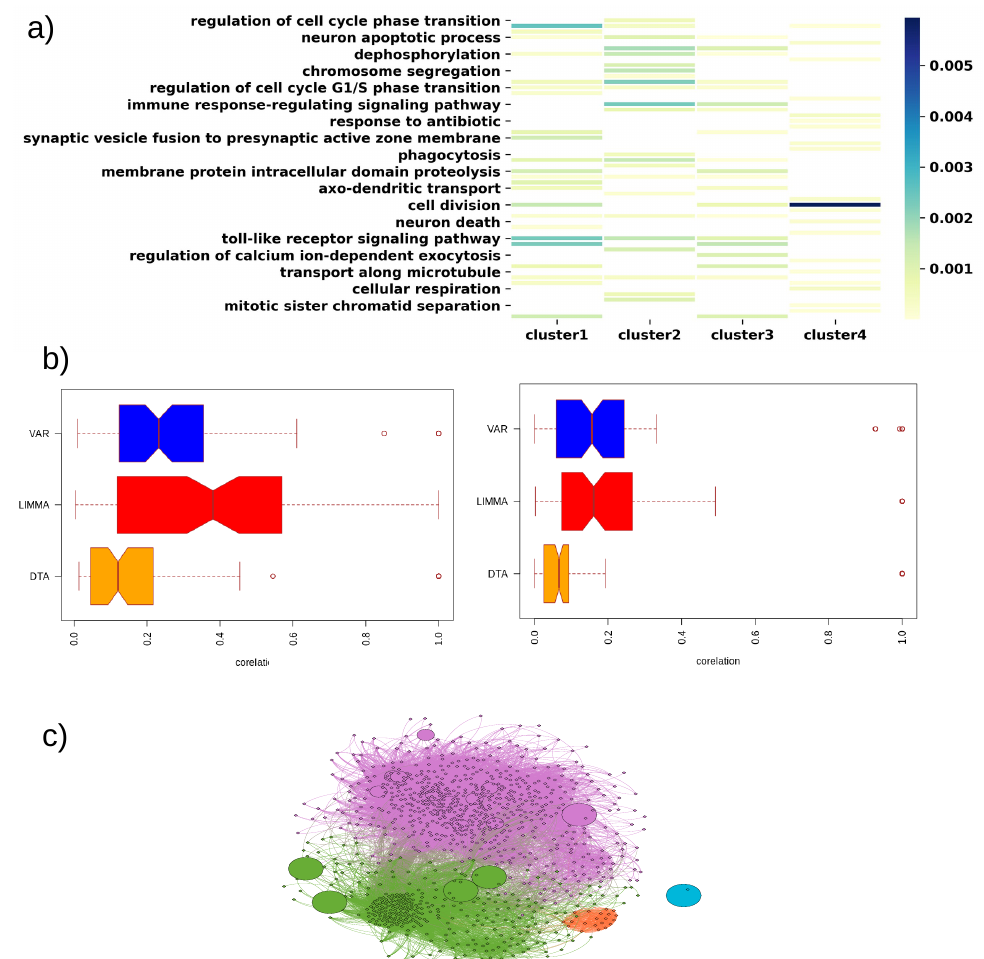
Figure 4. ( a ) Enriched biological functions of each subtype of GBM cancer type where DTA was used as a feature reduction technique. xlabel denotes the enriched biological terms and color intensity represents the p -value of the association; ( b ) analysis of how DTA selected features are different from those identified by other feature selection methods. Here, we compared the correction among the genes for different feature selection and DE methods. The left-side figure is for BRCA and the right side is for COAD; and ( c ) Predicted gene–gene interaction network of BRCA. The colors indicate five different clusters that were identified. The big circle shows the DTA selected genes, which are distributed over the network. The medium-sized circle denotes the genes selected by LIMMA, which mainly belong to one cluster (cluster with violet